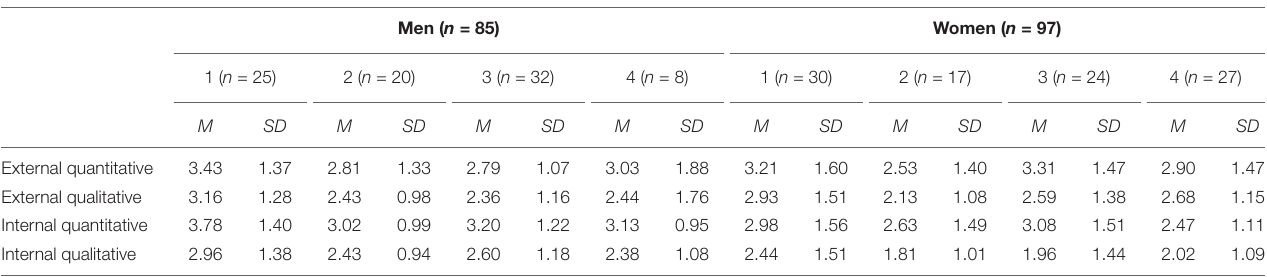
TABLE 2 | Descriptive statistics of employability by sex and gender identity among employees ( n = 182).